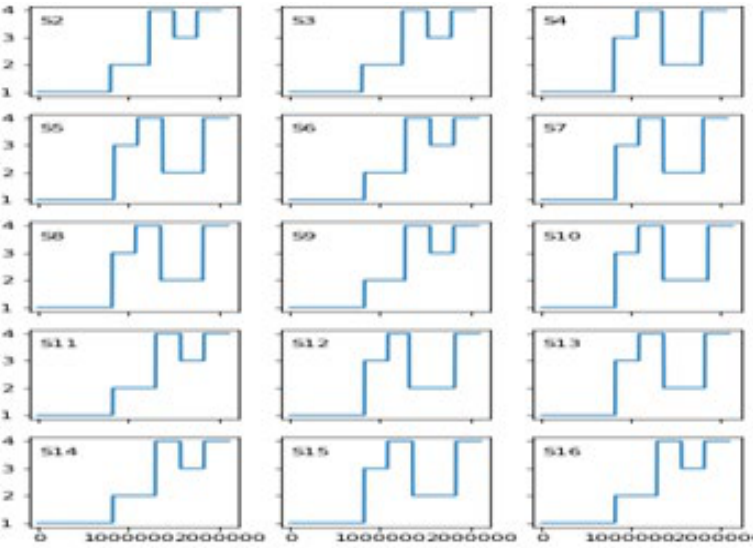
Fig. 4. Baseline (1), Stress (2), Meditation (3) and Amusement (4) vs Time plot for each subject.